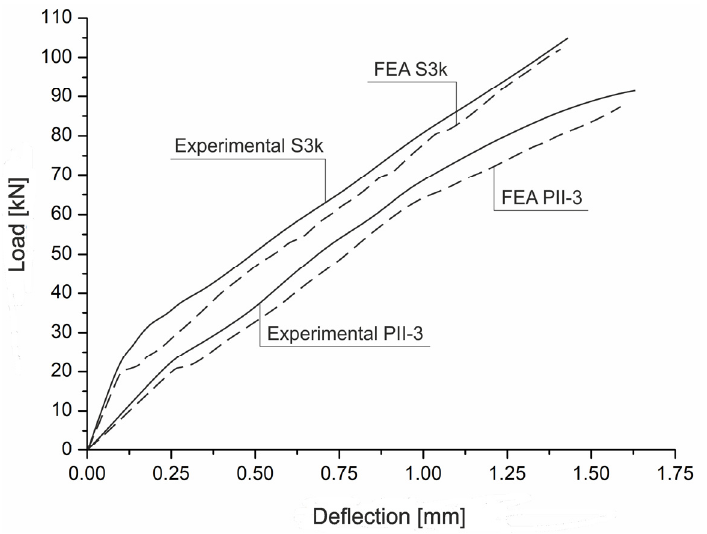
Figure 12. Load–deflection curves. Comparison of FEM results and test results for the slender beams PII-3 and S3k.